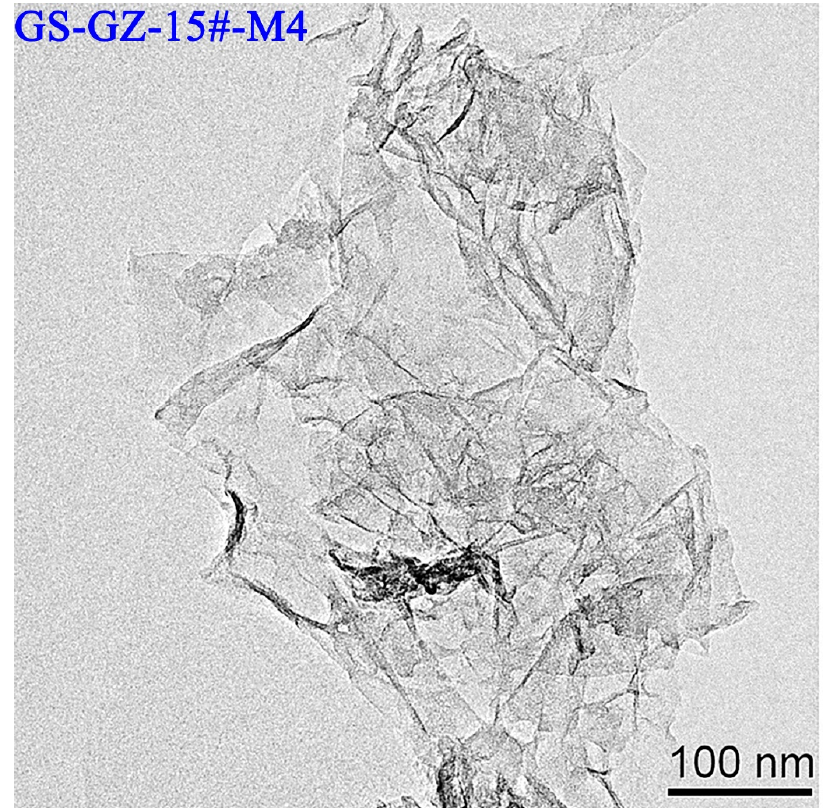
Figure 16. HRTEM image of coal graphene at large scale.